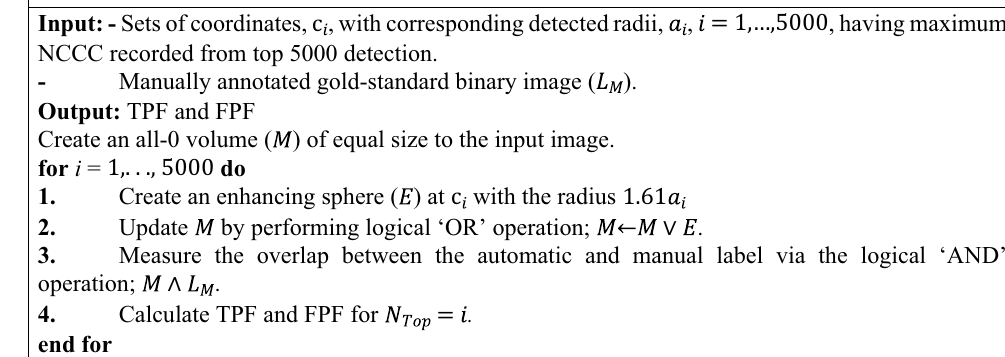
Algorithm 1: Performance evaluation of algorithms for automatic lesion detection from brain images